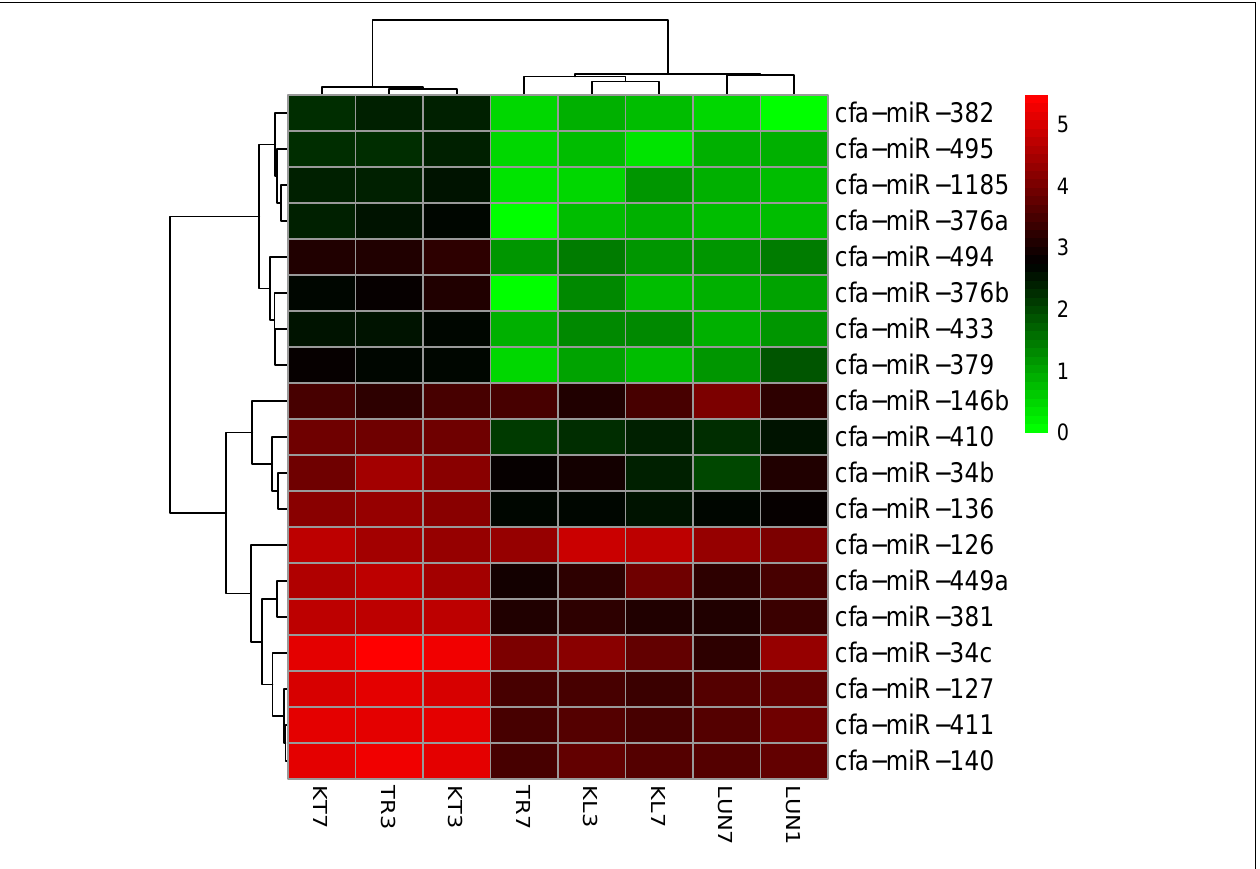
FIGURE 2 | Clustering of the 19 up-regulated and down-regulated DE miRNAs for assigning dogs to infected groups and non-infected groups. The colors in the heat map represent the normalized expression values, with lower expression values indicated in shades of green and higher expression values in shades of red.